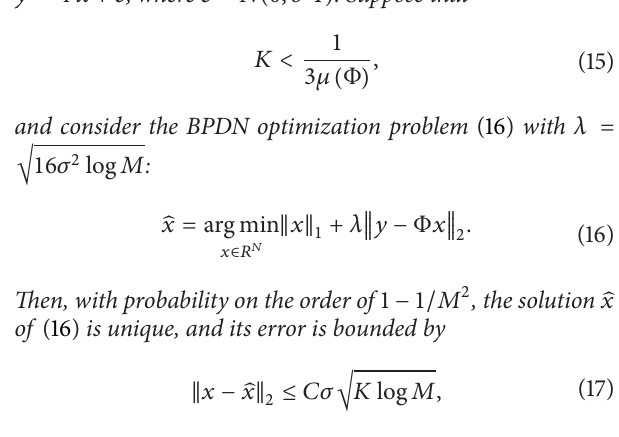
Algorithm 6. The coherent column replacement method